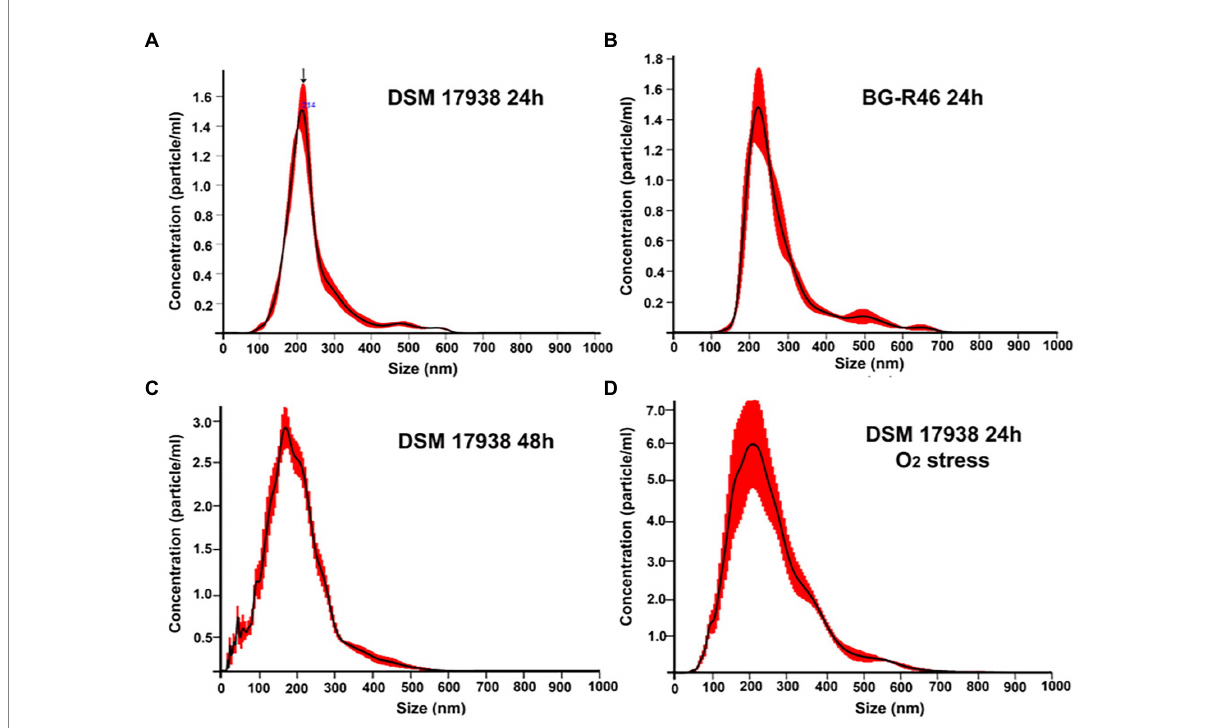
FIGURE 2 Physicochemical characterization of L. reuteri derived MV through NanoSight tracking analysis (NTA). The nanoparticle tracking distribution of L. reuteri DSM 17938 derived MV after 24 h, 48 h, under O 2 stress of cultivation and isolated from BG-R46 were shown in (A,C,D,B) individually. Figures are representative of three independent triplicates. The size distribution represents the wide distribution of MV for each MV prep. Arrow shows the mean peaks of particles at 214 nm (A) . Figure 2A was originally published in Scientific Reports (Mata Forsberg et al., 2019).